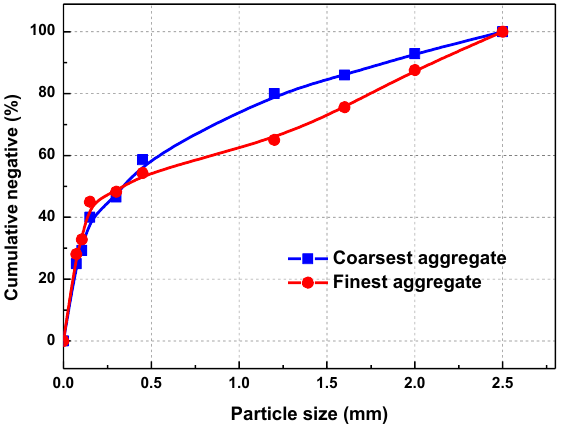
Figure 4. Particle-size distributions of the finest and coarsest aggregates in the high-strength region.